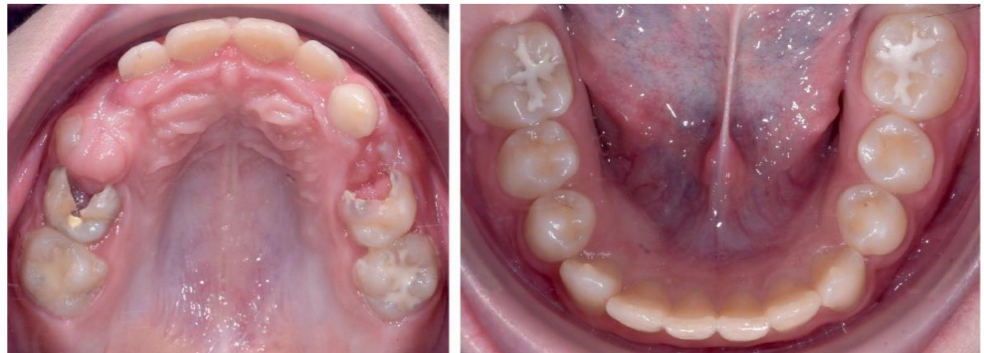
Figure 14. Post-splint therapy evaluation—intra-oral occlusal